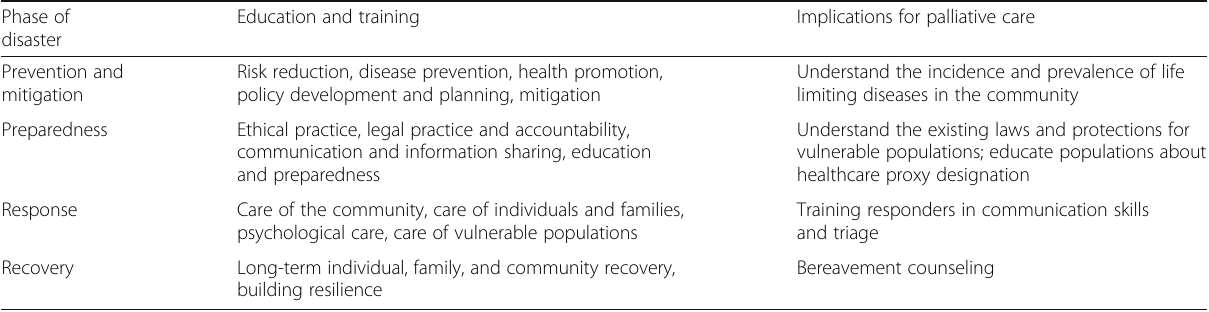
Table 2 C 3 DC model for disaster education